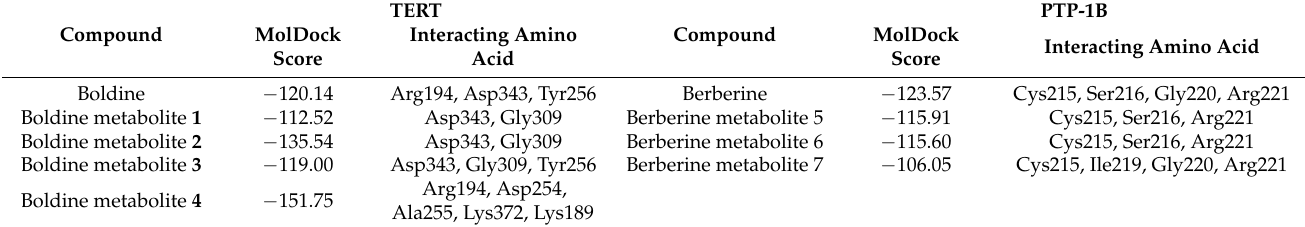
Table 3. Docking scores and the amino acids involved in hydrogen bonding interactions.